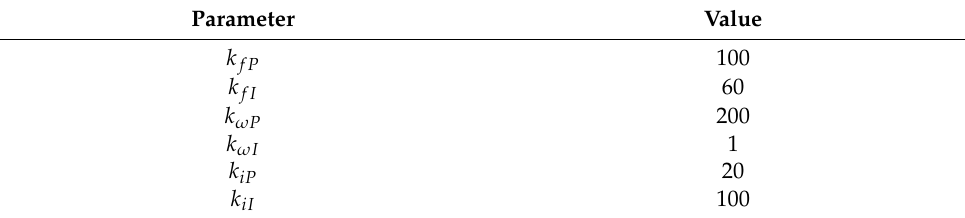
Figure 4. Vector control architecture. Table 2. Control gains for linear controller.